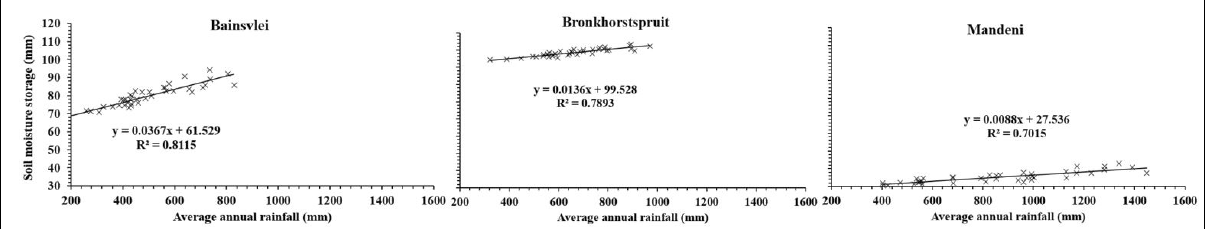
Figure 4: Regression plots of average annual rainfall and average annual soil moisture over 39 years at three different